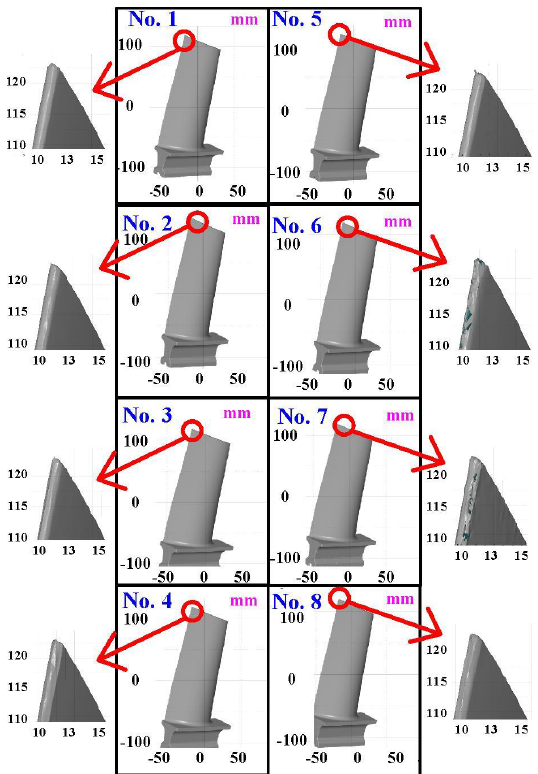
Figure 5. Measurement results of the as-cast turbine blade that was not sprayed with a mixture of ethanol and TiO 2 powder.